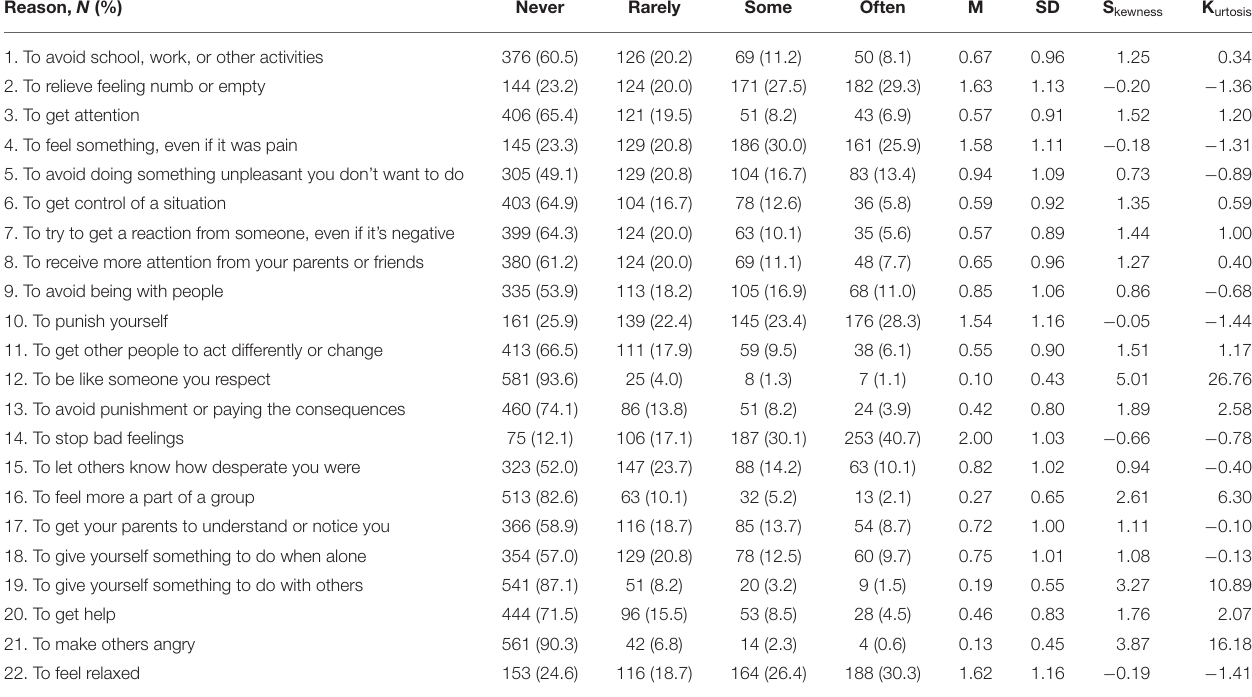
TABLE 2 | Distribution of responses for FASM function checklist ( N = 621). Reason, N